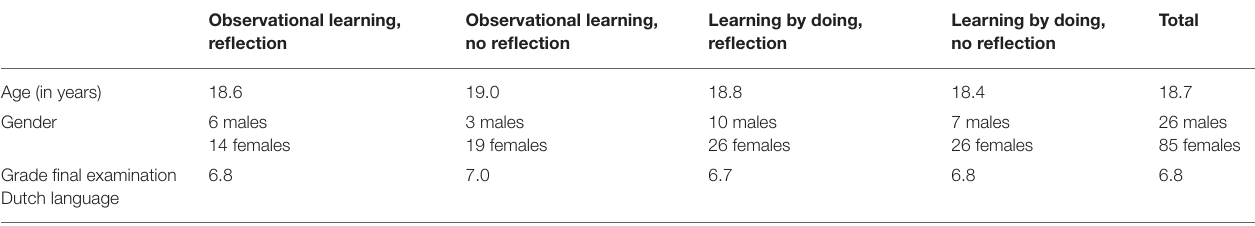
TABLE 2 | Descriptives participants per condition.